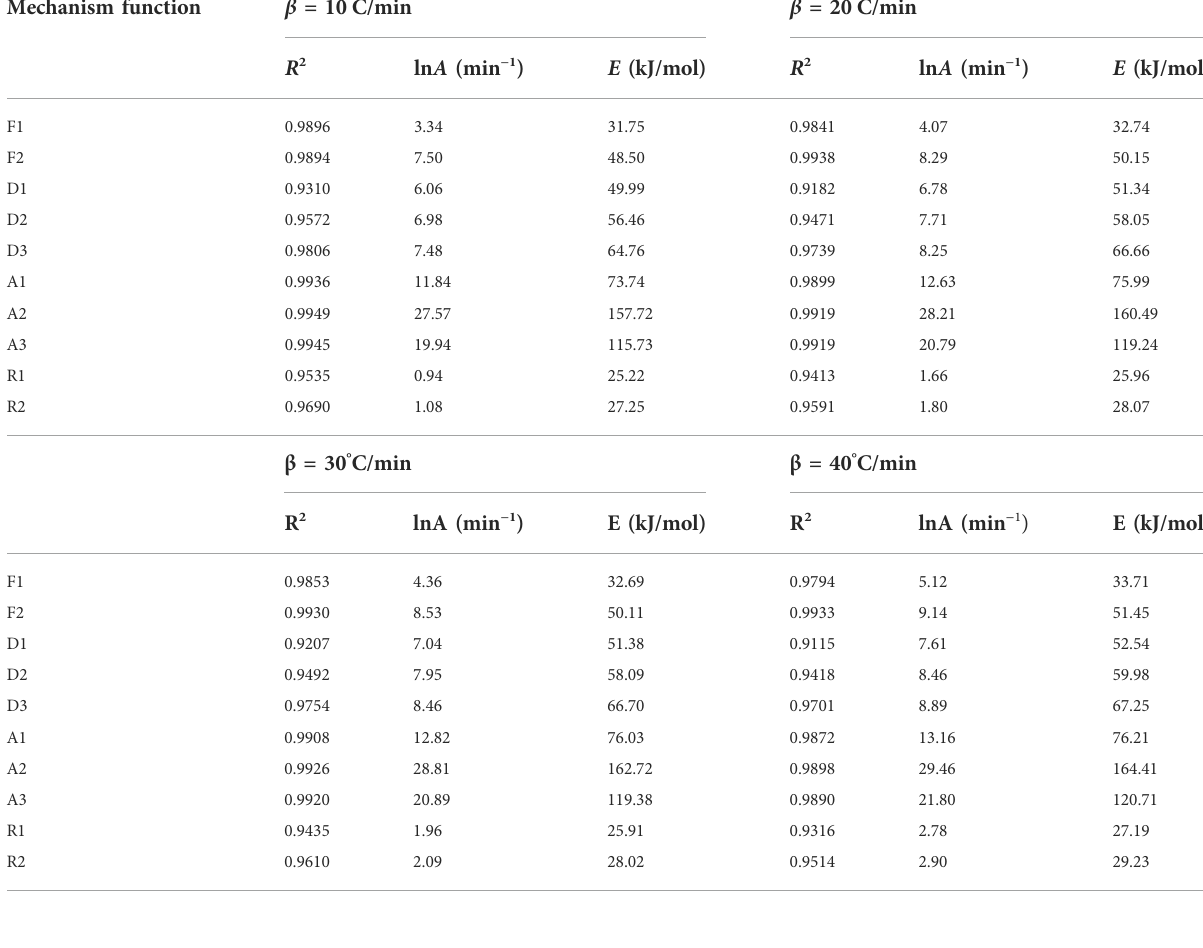
TABLE 4 Kinetic parameters of Coats-Redfern method for different heating rates.